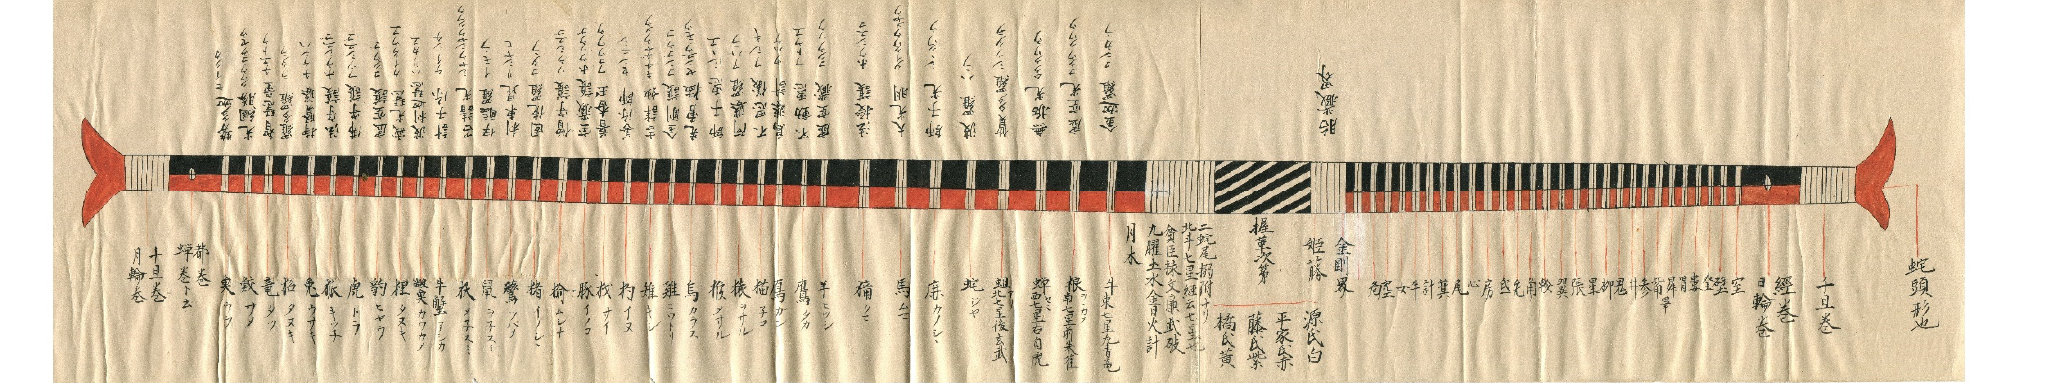
Figure 1. Serpent-Headed Bow. Icch ō ky ū no maki (Scroll of the One Bow, 1819). This bow is also referred to in other sources as the “mandalic bow” ( mandara-ky ū 曼荼羅弓 ). Author’s private possession.